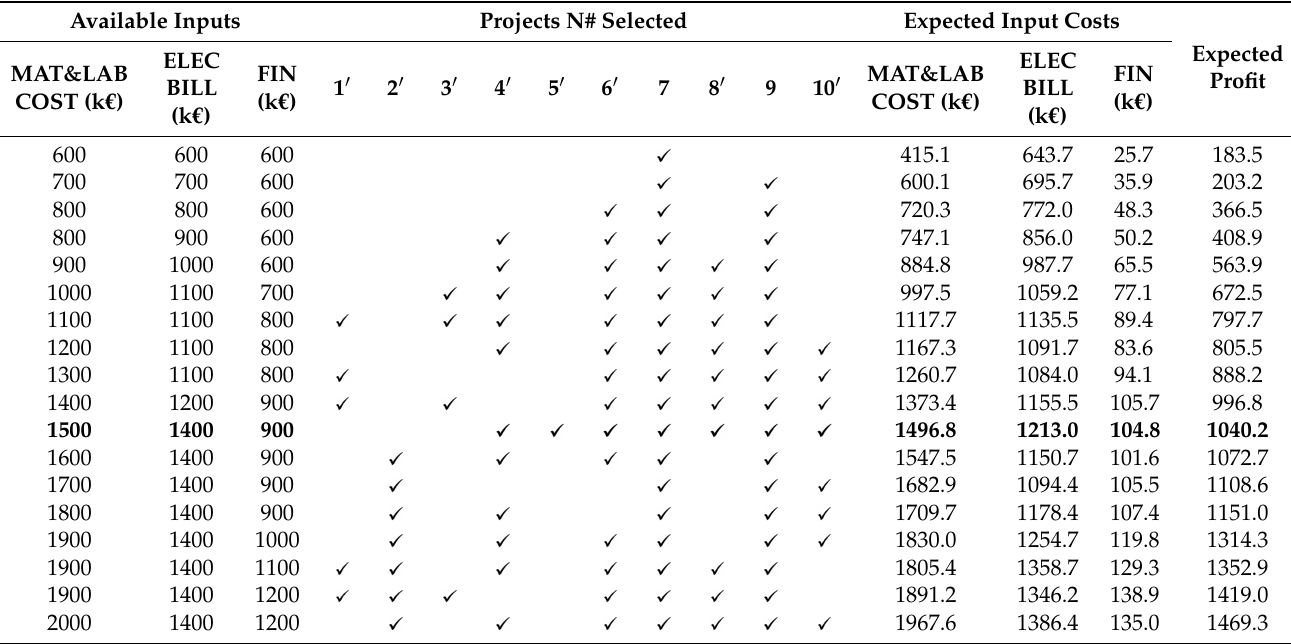
Table 5. Dependence of the selection projects solution on the available